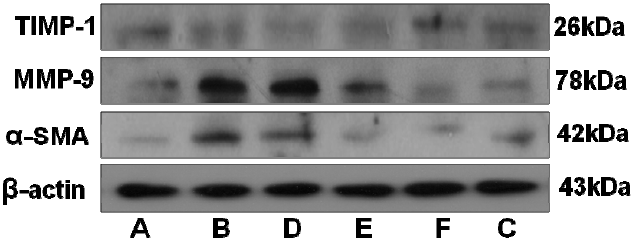
Figure 8. Expression level of TIMP-1, MMP-9 and α -SMA of the lung tissues in rats. ( A ) normal group; ( B ) model group; ( C ) PAG group; ( D – F ) are RRL groups treated with 125, 250 and 500 mg/kg, respectively.